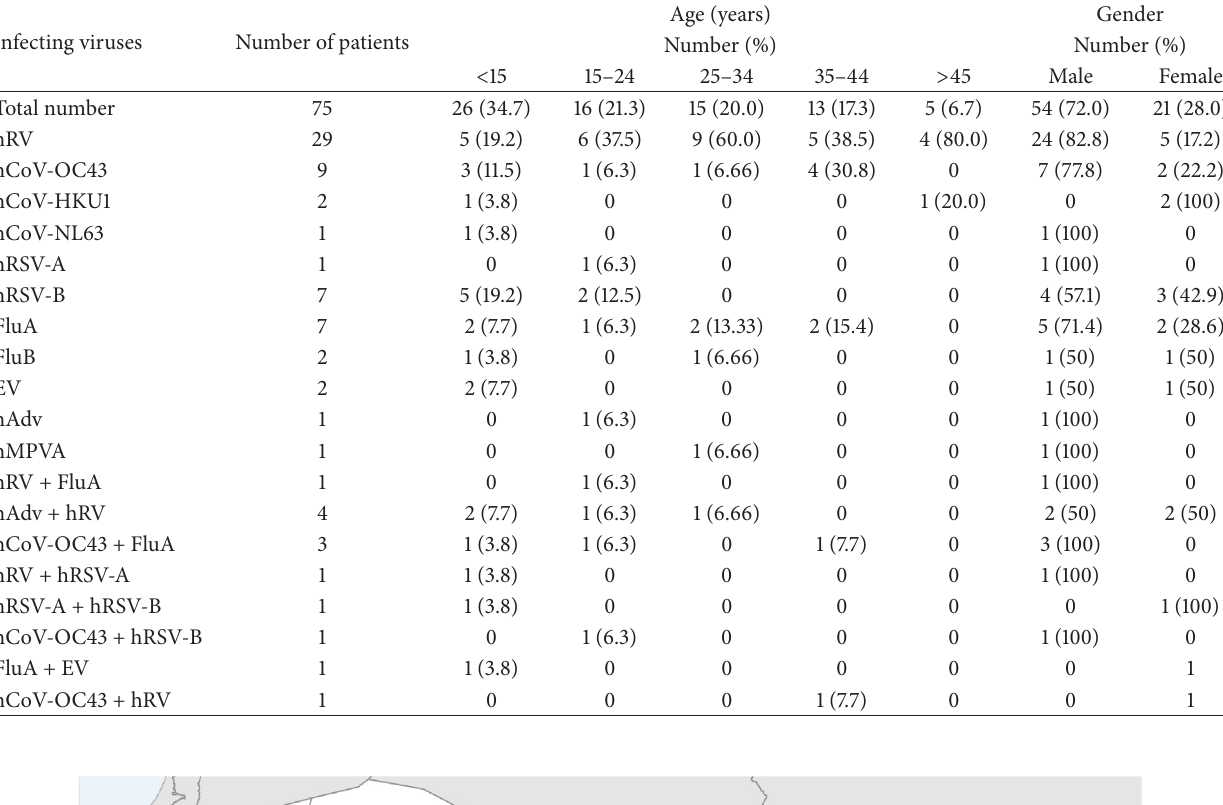
Table 3: Demographic data of patients with upper respiratory tract infection by pathogen.